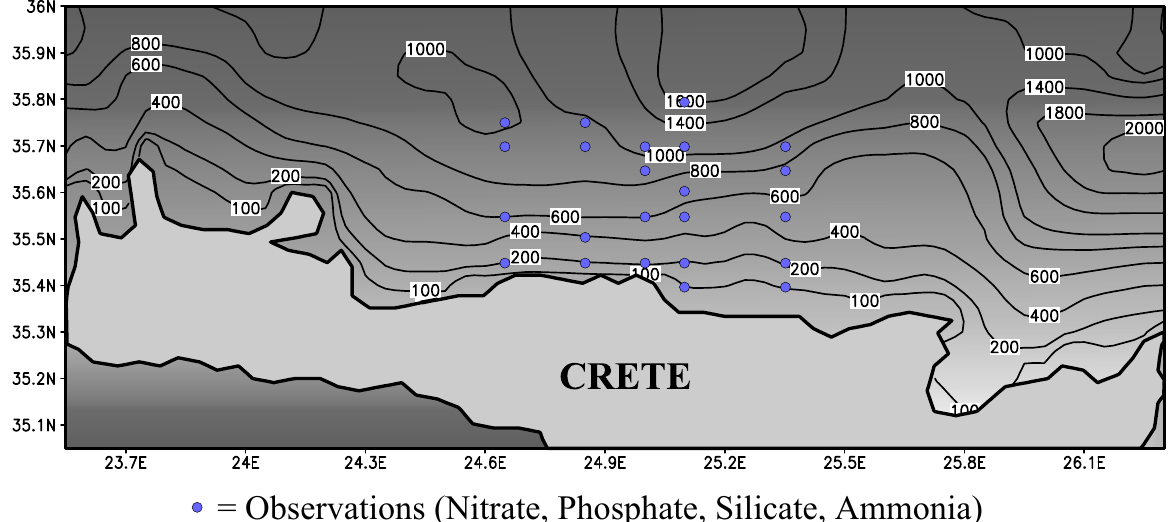
= Observations (Nitrate, Phosphate, Silicate, Ammonia) Fig. 2. Simulation domain with locations for profiles (pseudo) observations of nitrate, phosphate, silicate and